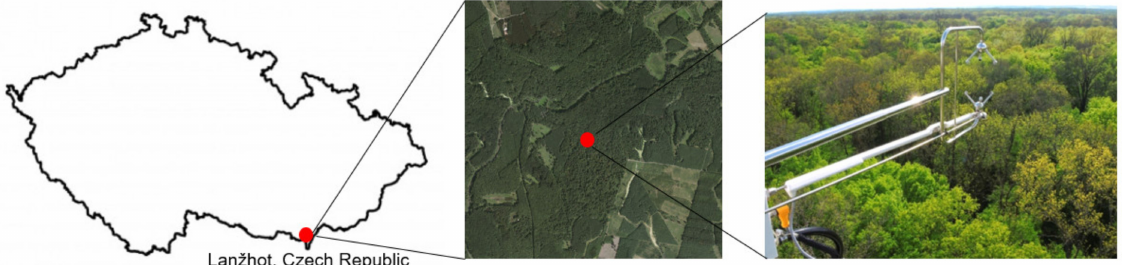
Figure 1. Map of Czech Republic ( left ), the study site Lanžhot with the location of the EC tower ( middle ) and the view of the floodplain forest ecosystem from above ( right